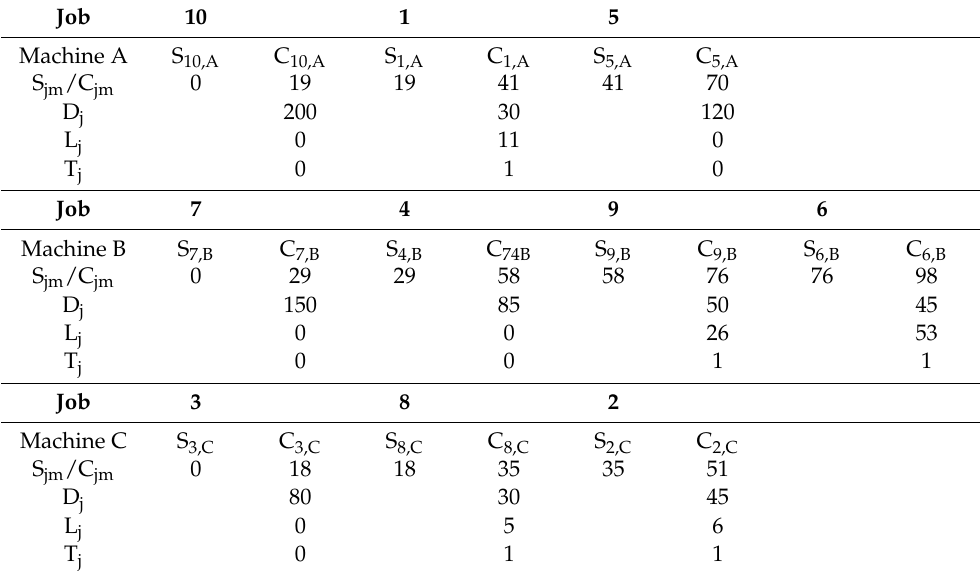
Table 5. Sequence and scheduling from Table